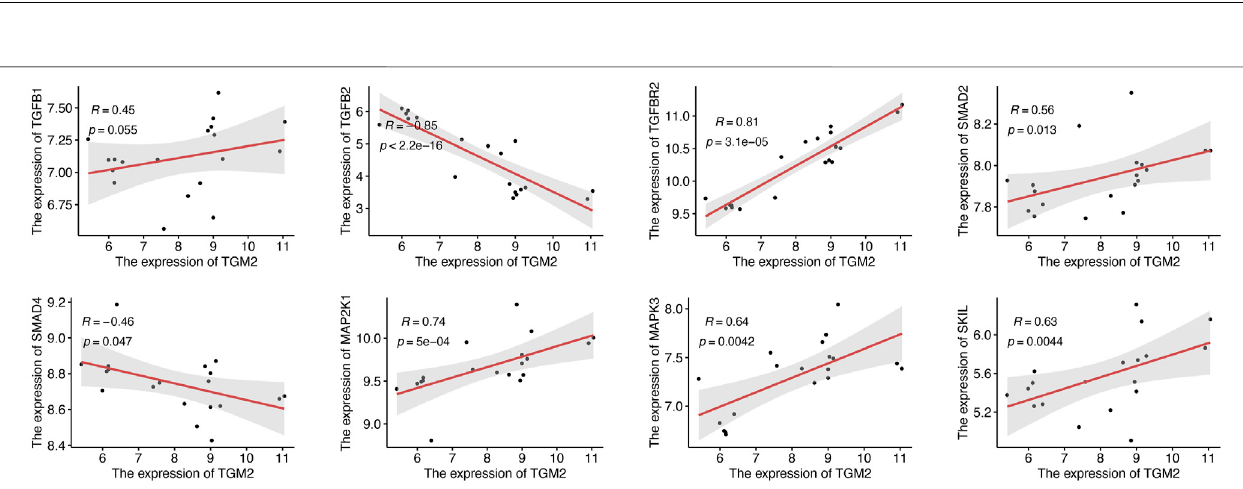
FIGURE 6 | Correlation analysis of TGM2 and the TGF-beta signaling pathway in keloids. The scatter plots illustrated the molecules that were signi fi cantly correlated with TGM2. Due to the important role of TGF- β 1 in the TGF-beta signaling pathway, the scatter plot of the correlation between TGF- β 1 and TGM2 was